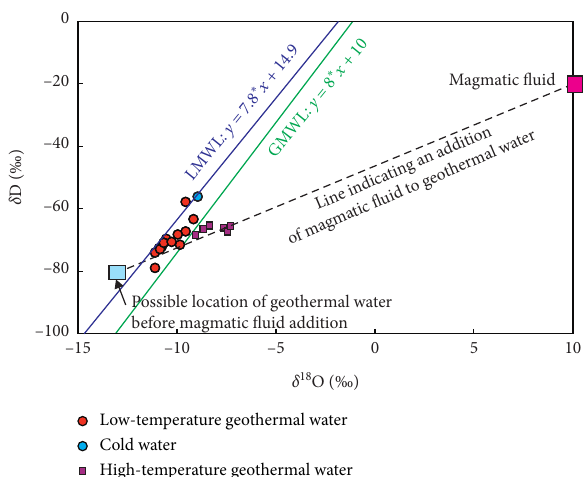
Figure 9: Plots of δ 18 O vs. δ D for the geothermal water and cold water samples, modified after [17]. GMWL, global meteoric water line; LMWL, local meteoric water line. Low-temperature geothermal water and cold water samples are from this study. High-temperature geothermal water samples are cited from